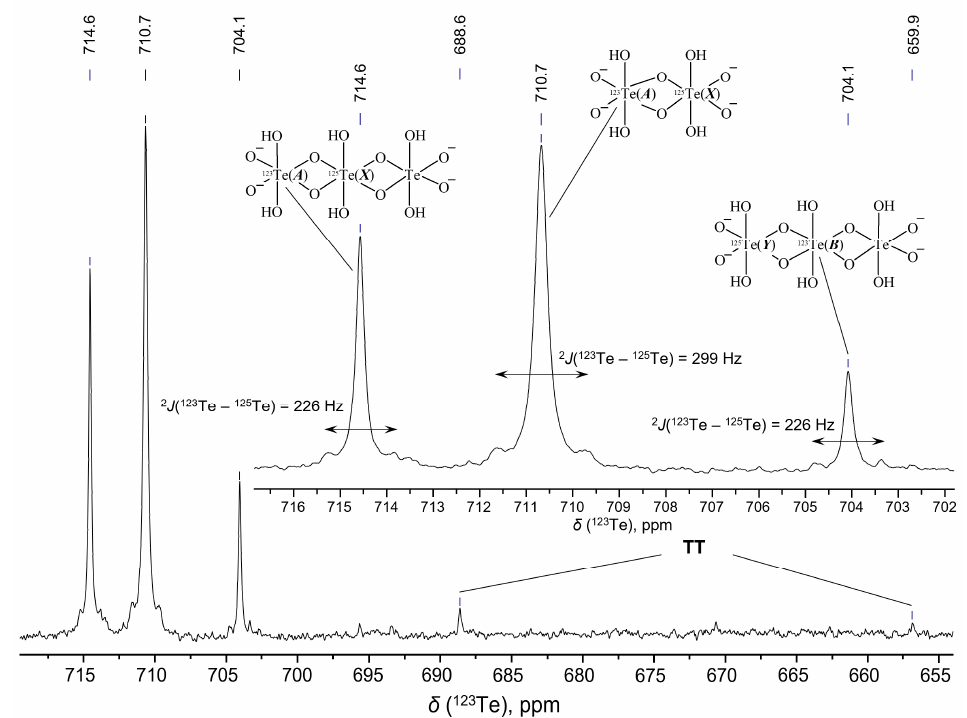
Figure 4. 123 Te NMR spectrum of 1 M solution of Cs 4 [Te 2 O 10 H 4 ] in water (pH 14.4) (Bruker Avance- 600, Bruker BioSpin GmbH, Ettlingen, Germany).